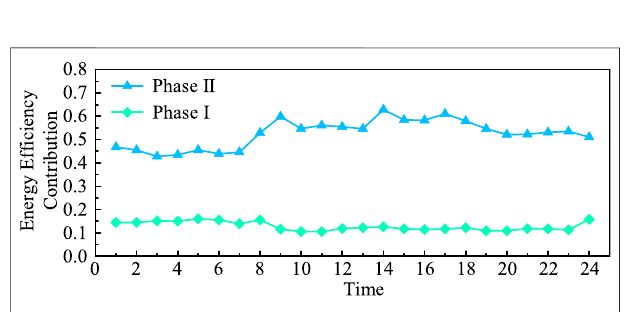
FIGURE 7 | The comparison of the natural gas